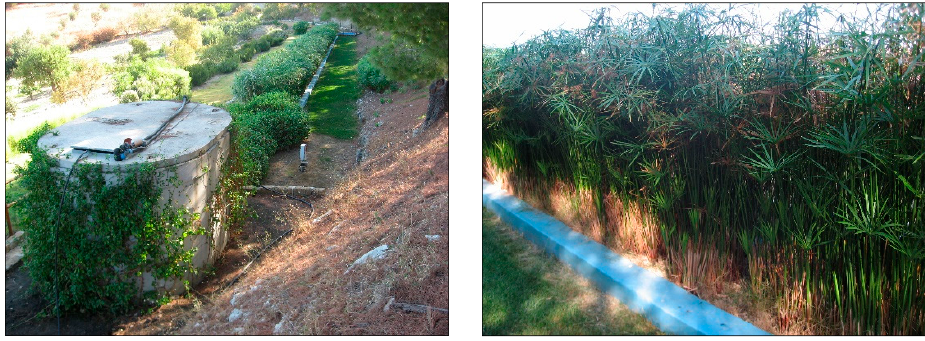
Figure 1. A view of the HSSFs CW.